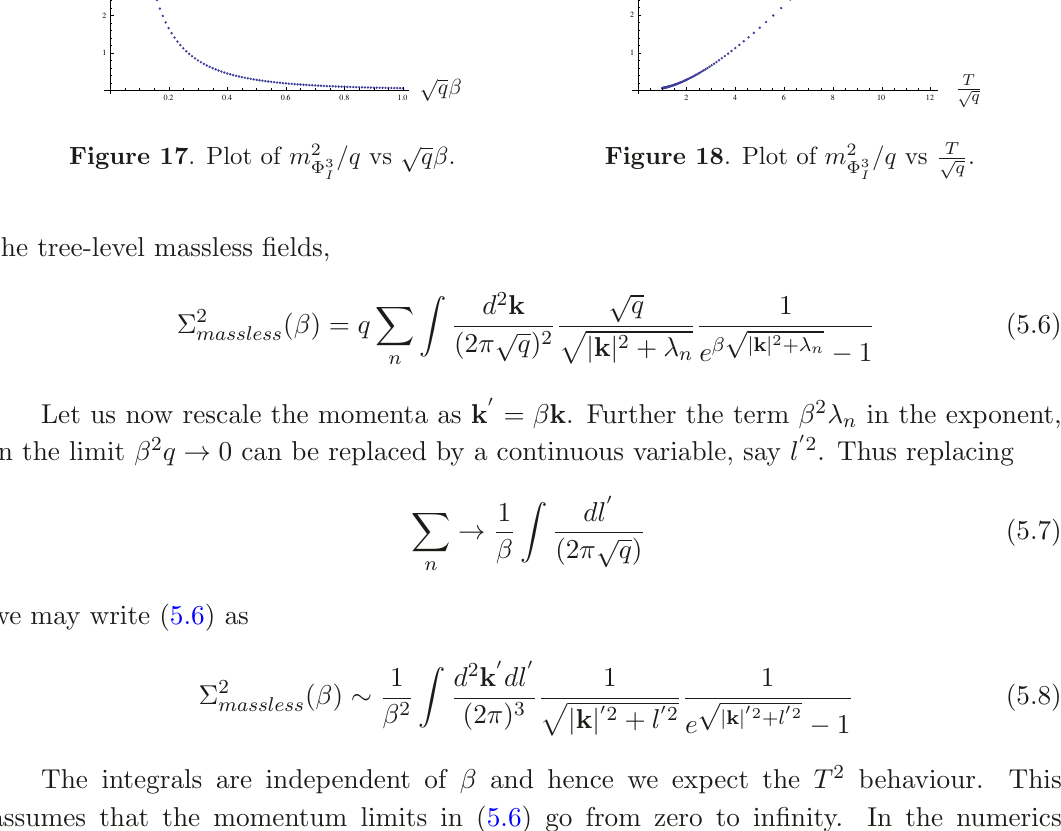
/q vs √ qβ . Figure 16 . Plot of m 2 Φ 3 1